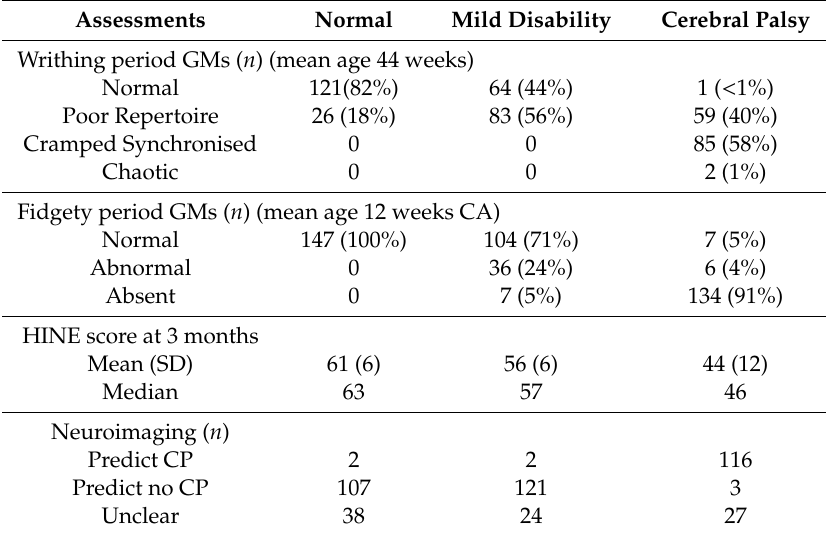
Table 2. Distribution of test results across 3